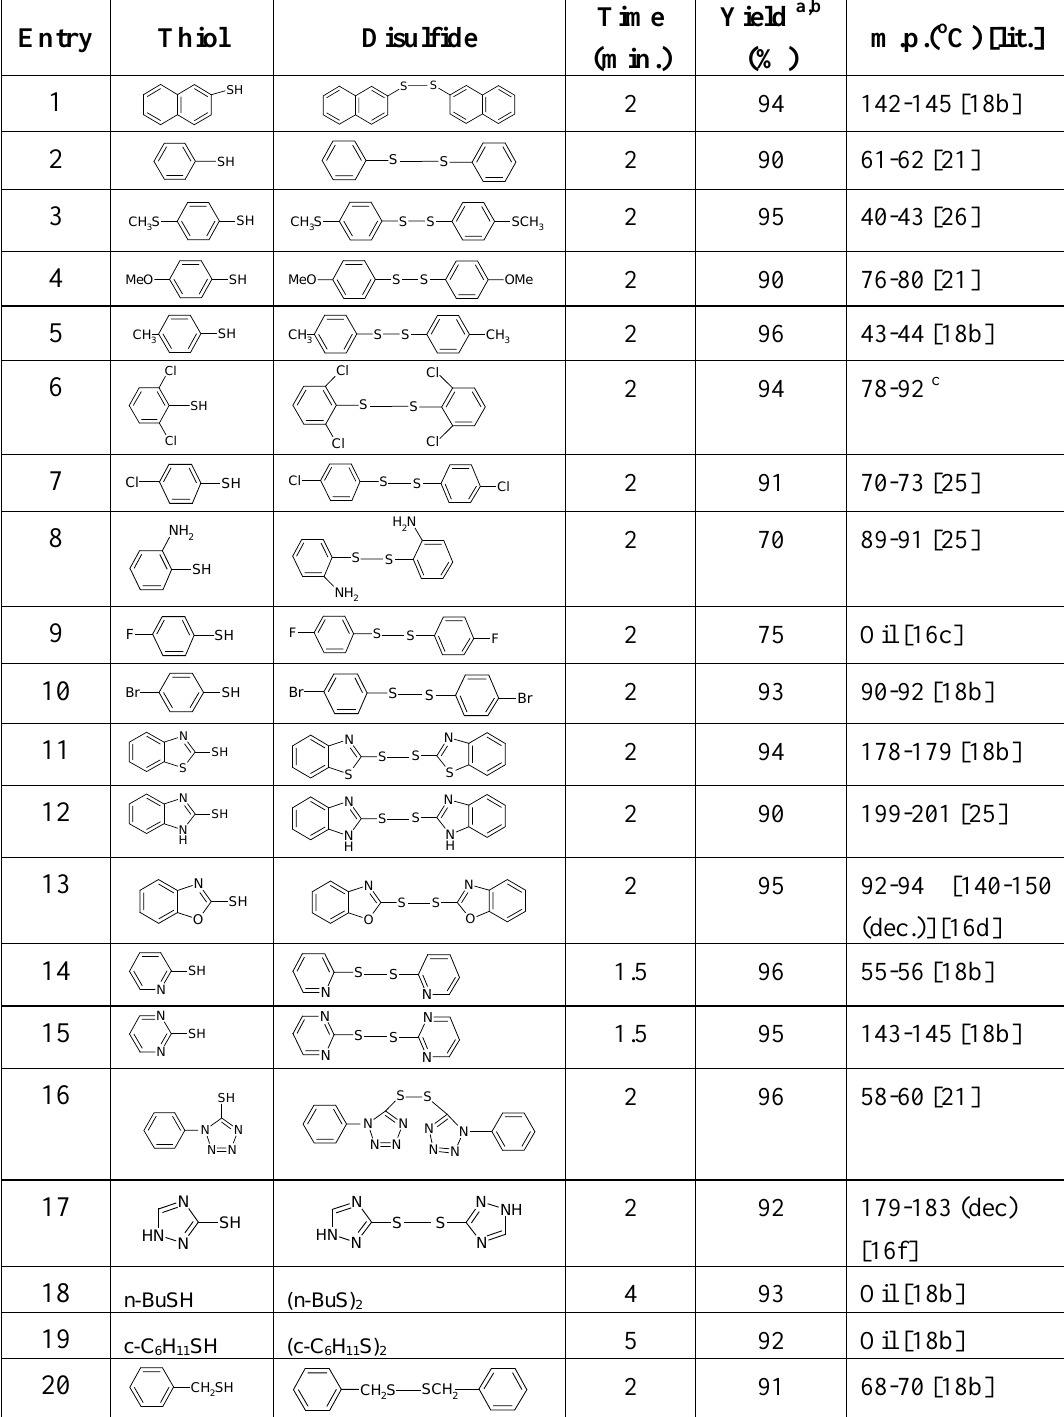
Table 1 . Solid state oxidation of thiols to corresponding disulfides using moist (10%) sodium periodate at room